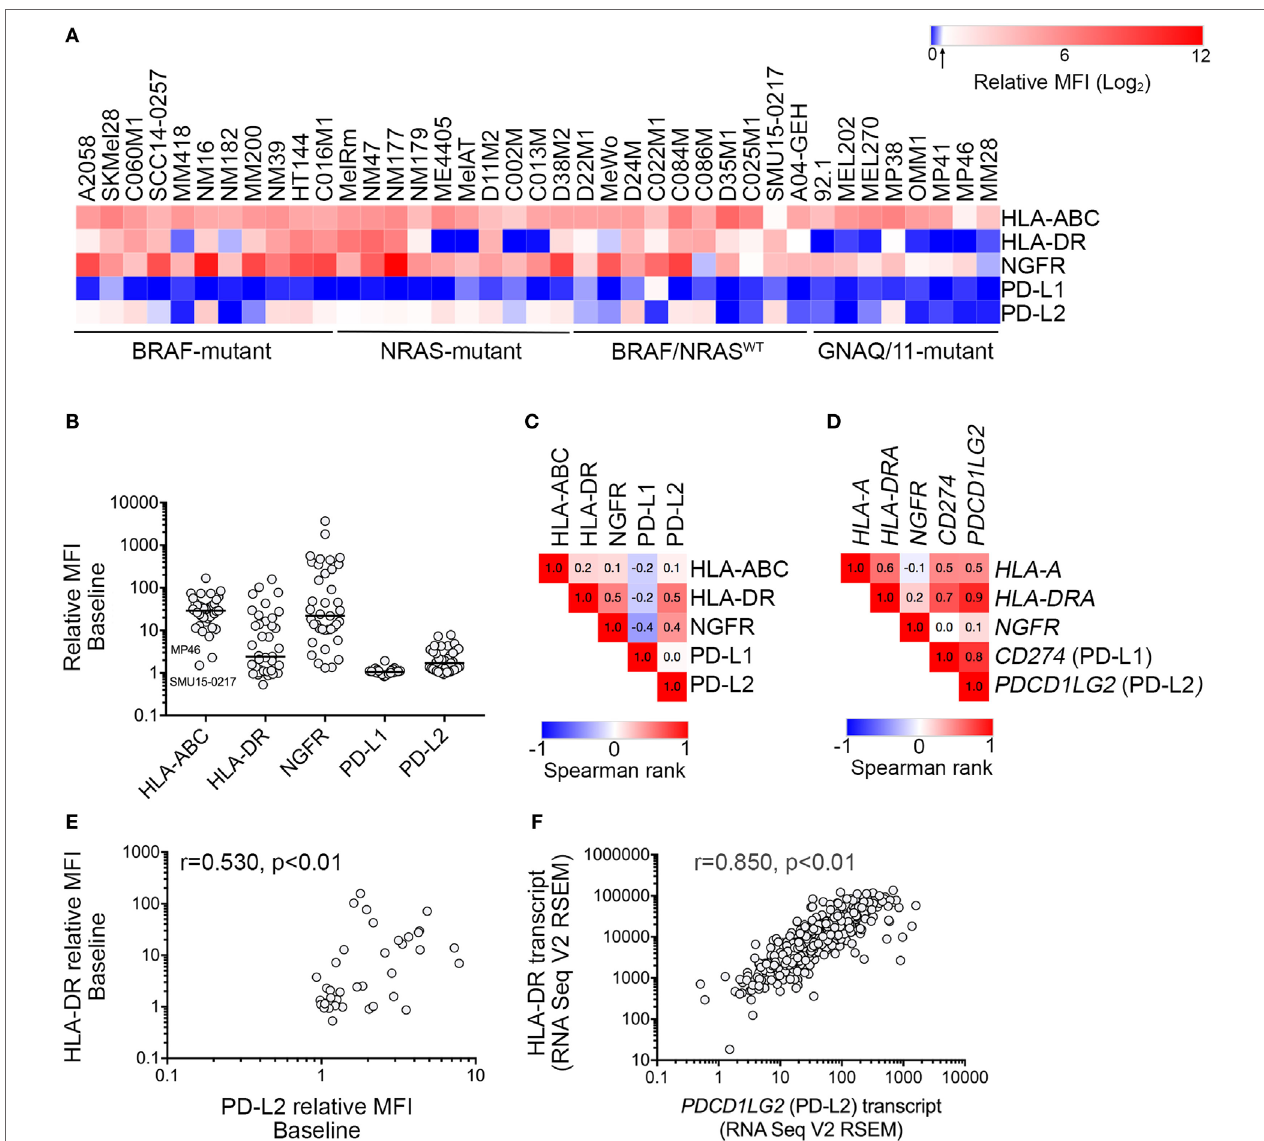
FigUre 1 | Expression of downstream interferon- γ targets in melanoma cells. (a) Heatmap showing cell surface expression [relative mean fluorescence intensity (MFI); mean of two to five independent experiments] of HLA-ABC, HLA-DR, nerve growth factor receptor (NGFR), PD-L1, and PD-L2 in 39 melanoma cell lines with defined oncogenic drivers including 11 BRAF V600 -mutant, 10 NRAS -mutant, 10 BRAF/NRAS wild type ( BRAF/NRAS WT ), and 8 GNAQ/11 -mutant uveal melanoma cell lines. Relative MFI < 1.5 is indicated by the arrow on the color bar. (B) Cell surface baseline expression (relative MFI) of HLA-ABC, HLA-DR, NGFR, PD-L1, and PD-L2 in a panel of 39 melanoma cell lines. Each dot represents one cell line and the median expression is indicated by the horizontal line. Low cell surface expression of HLA-ABC on the MP46 and SMU15-0217 cell lines is indicated. (c) Correlation matrix showing Spearman’s rank correlation analysis between cell surface expression of markers, as indicated. Spearman’s rank correlation values are shown within the similarity matrix. (D) Correlation matrix showing Spearman’s rank correlation analysis between transcript levels of HLA-A , HLA-DRA , NGFR , PD-L1 , and PD-L2 (The Cancer Genome Atlas (TCGA) skin cutaneous melanoma (SKCM) dataset). Spearman’s rank correlation is shown within the similarity matrix. (e) Correlation between PD-L2 and HLA-DR cell surface expression and (F) mRNA transcript expression (TCGA SKCM dataset). Spearman’s rank correlation coefficient and p values are